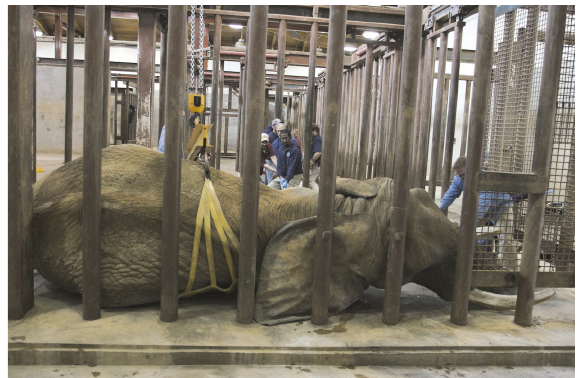
Figure 3: The original plan was to perform surgery on the right eye, if possible, but the elephant went into right lateral recumbency and could not be maneuvered into left lateral recumbency. As a result, surgery was performed on his left eye.